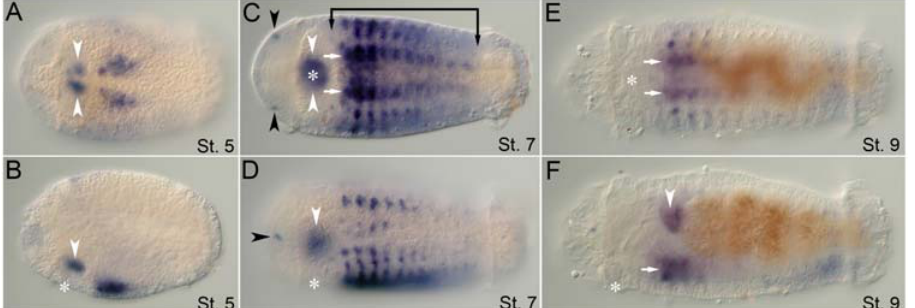
Figure 3. Expression of CapI-lab during larval development as analyzed by in situ hybridization. Anterior is to the left for all panels. Stages are indicated at bottom right of each panel. (A), (C), and (E) show ventral views; (B), (D), and (F), lateral views. Asterisk marks position of the mouth. (A, B) At stage 5, CapI-lab is expressed in the dorsal wall of the stomodeum (white arrowheads) and in bilateral patches of anterior ectoderm. (C, D) CapI-lab expression at mid-stage 7 includes two clusters of 2 to 3 cells in head ectoderm (black arrowheads), dorsolateral and ventrolateral ectodermal domains and foregut tissue (white arrowheads). Bracket denotes anterior and posterior borders of CapI-lab expression in the mid-body. White arrows mark staining in the VNC. (E, F) Expression in the VNC (white arrows) and the posterior of the esophagus (white arrowhead) persists to the end of larval development (stage 9).